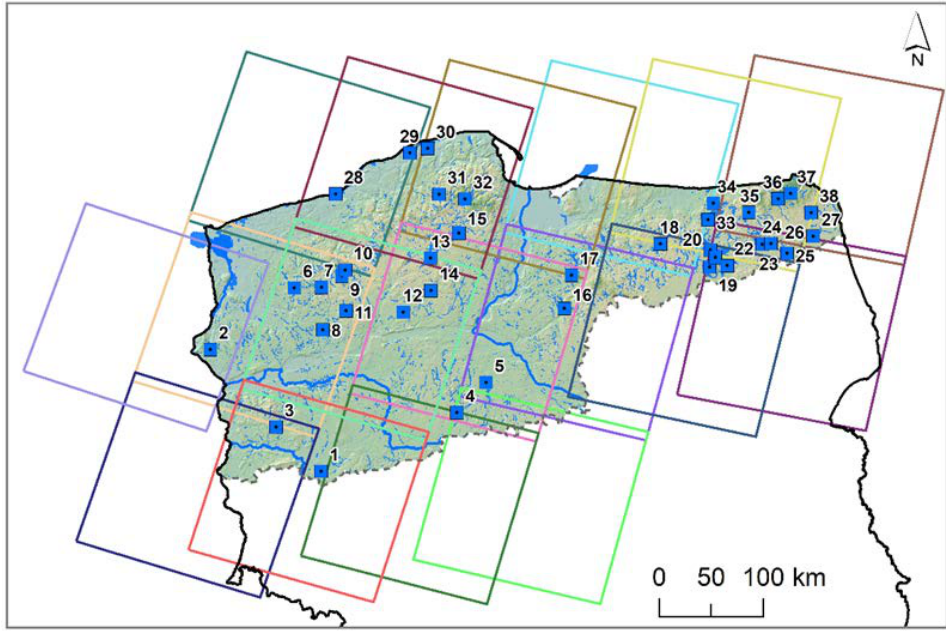
Figure 3. Landsat 8 Collection 2 Level 1 processed scenes. Numbering of lakes (1–38) according to Supplementary Table S1.